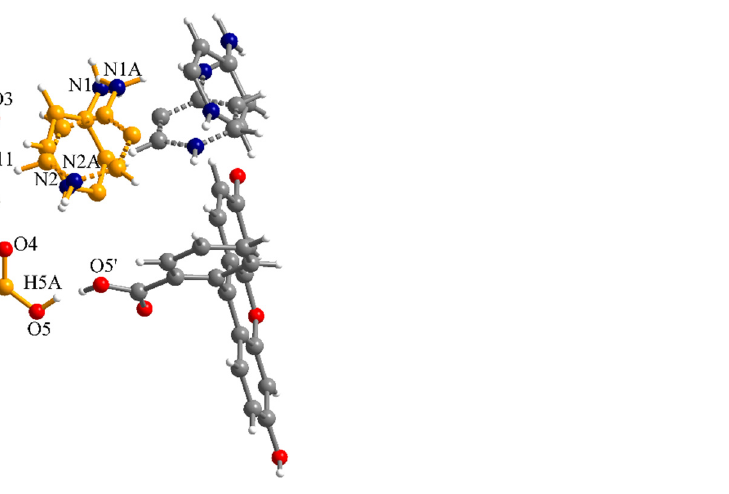
Figure 13. Crystal structure of 7 . The asymmetric unit is depicted in orange. Symmetry code: ’ = − x, y, 1.5 − z. y, 1.5 − z.